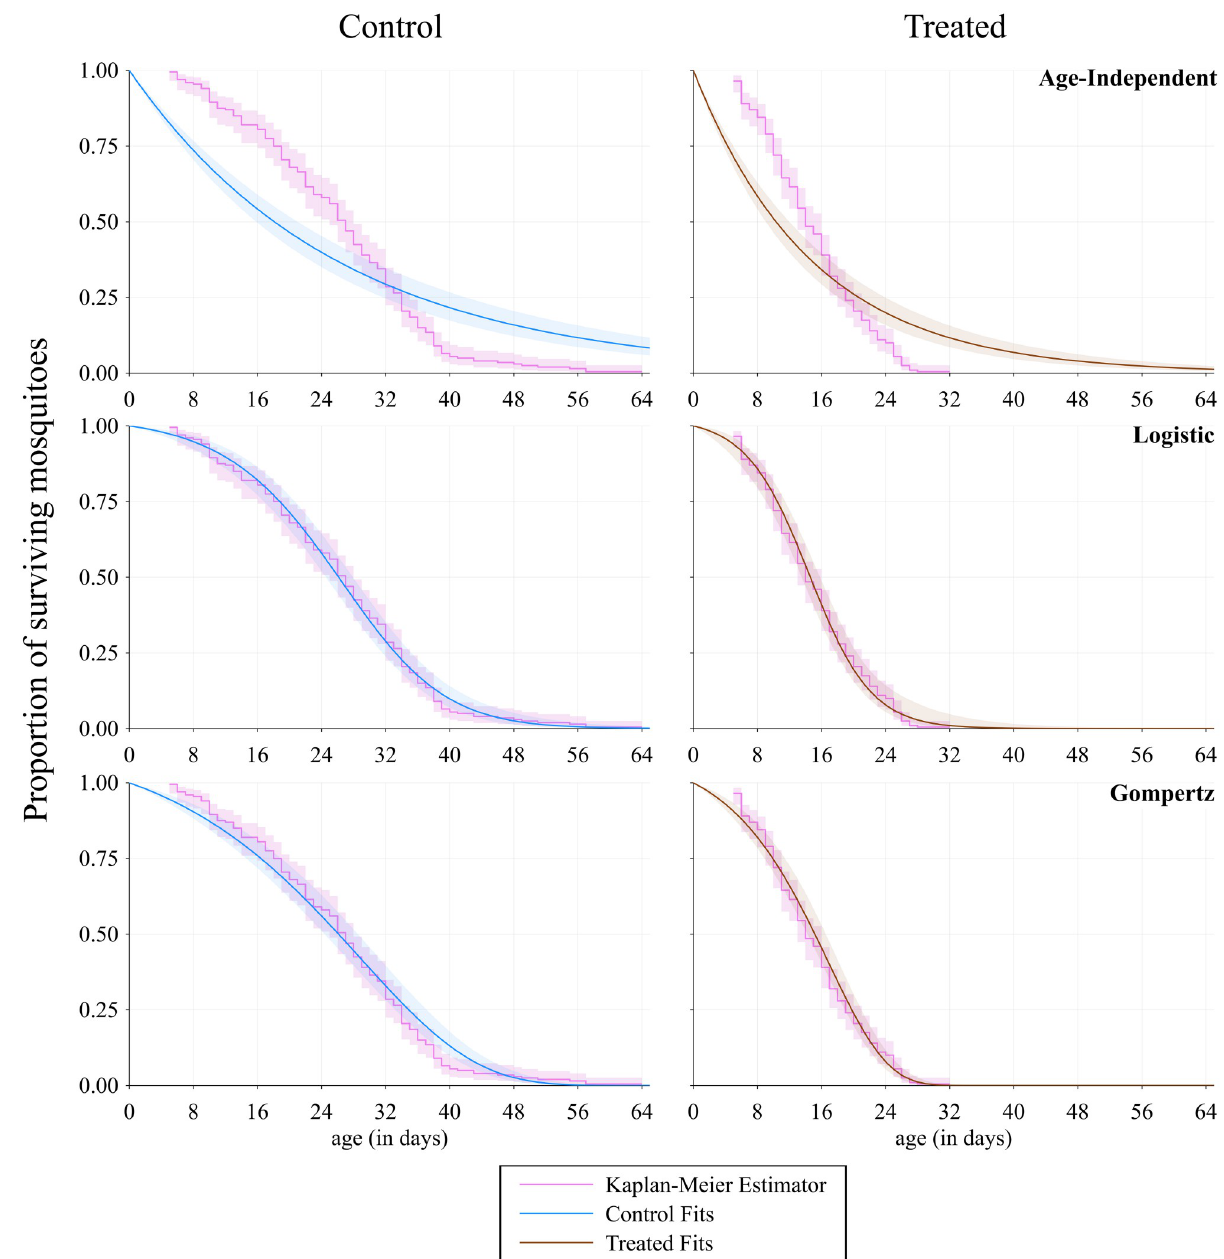
Fig 3. Fitted survival functions. Plots for the proportion of surviving mosquitoes at each day for the control (non-exposed) and treated (exposed) cases using the three different survival functions (age-independent, logistic, Gompertz). In the treated column, all mosquitoes are dead by day 33. The fits are extended to day 64 for a better comparison between the two treatments. The shaded area around the control and treated curves represents the 95% confidence interval due to the error propagated from the parameter estimates in each function using Monte Carlo simulations. The shaded area around the Kaplan-Meier estimator represents the pointwise log-log transformed 95% confidence